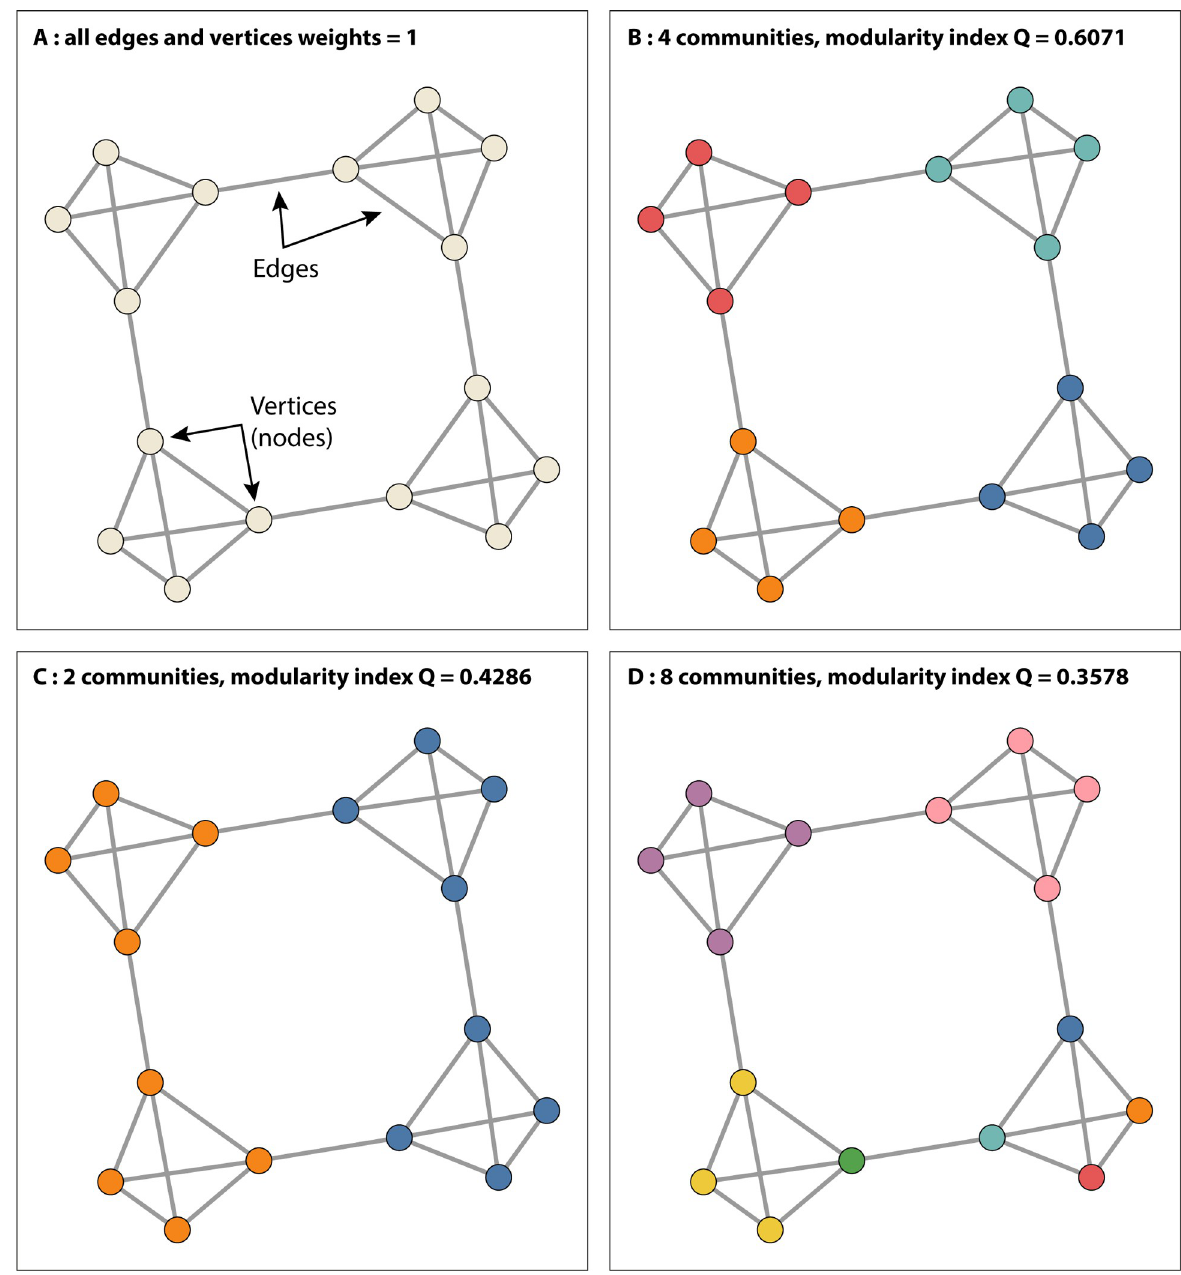
Fig 1. Illustration of the modularity index. In this fictitious configuration where 16 vertices form a network (panel A), we try to highlight some subgroups that are naturally communicate with one another. This scenario would naturally lead us to form four communities (panel B). The achieved modularity index is maximum (Q = 0.6071). Conversely, other configurations with 2 or 8 communities (panel C and D) reduce the Q index (0.4286 and